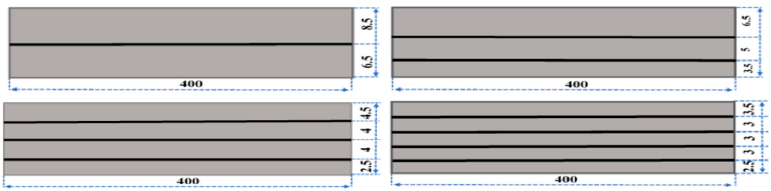
Table 2. Composition of geopolymer mortar